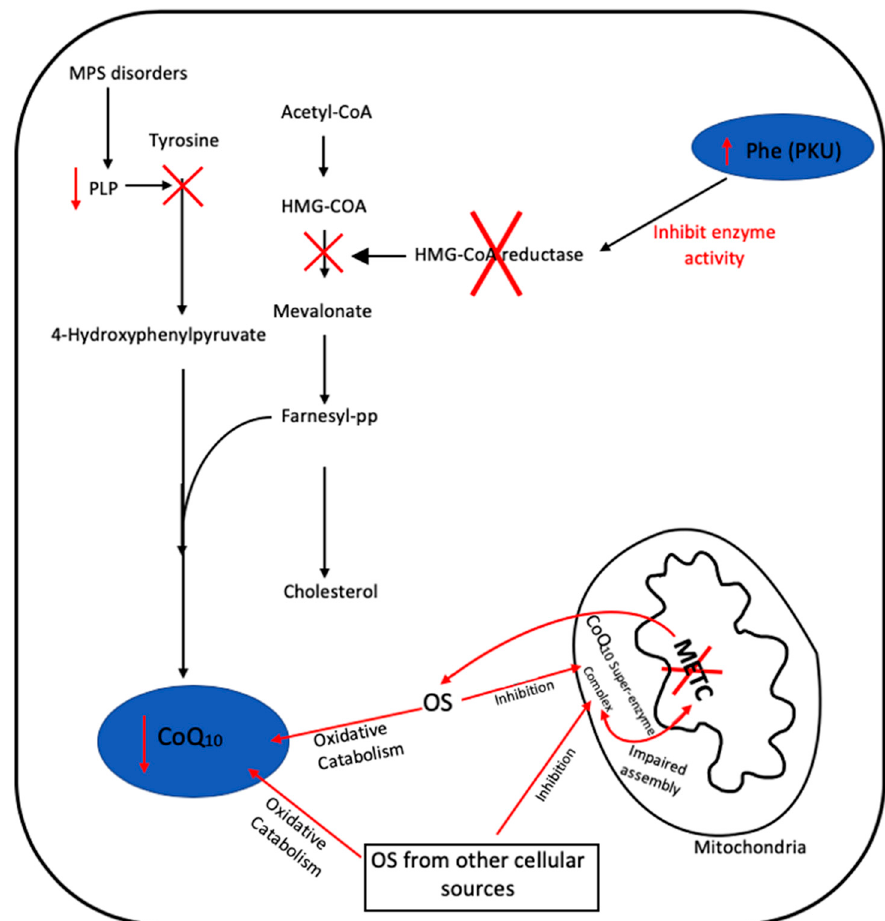
Figure 4. Putative mechanisms responsible for secondary CoQ 10 in disease in MPS, PKU and METC disorders. Oxidative stress (OS), pyridoxal 5-phosphate (PLP), mucopolysaccharidosis (MPS), phenylketonuria (PKU), phenylalanine (Phe) and mitochondrial electron transport chain (METC). Black arrows represent defined biochemical reactions; red arrows represent tentative biochemical reactions. `X` represents the inhibition of an enzyme or biosynthetic step.